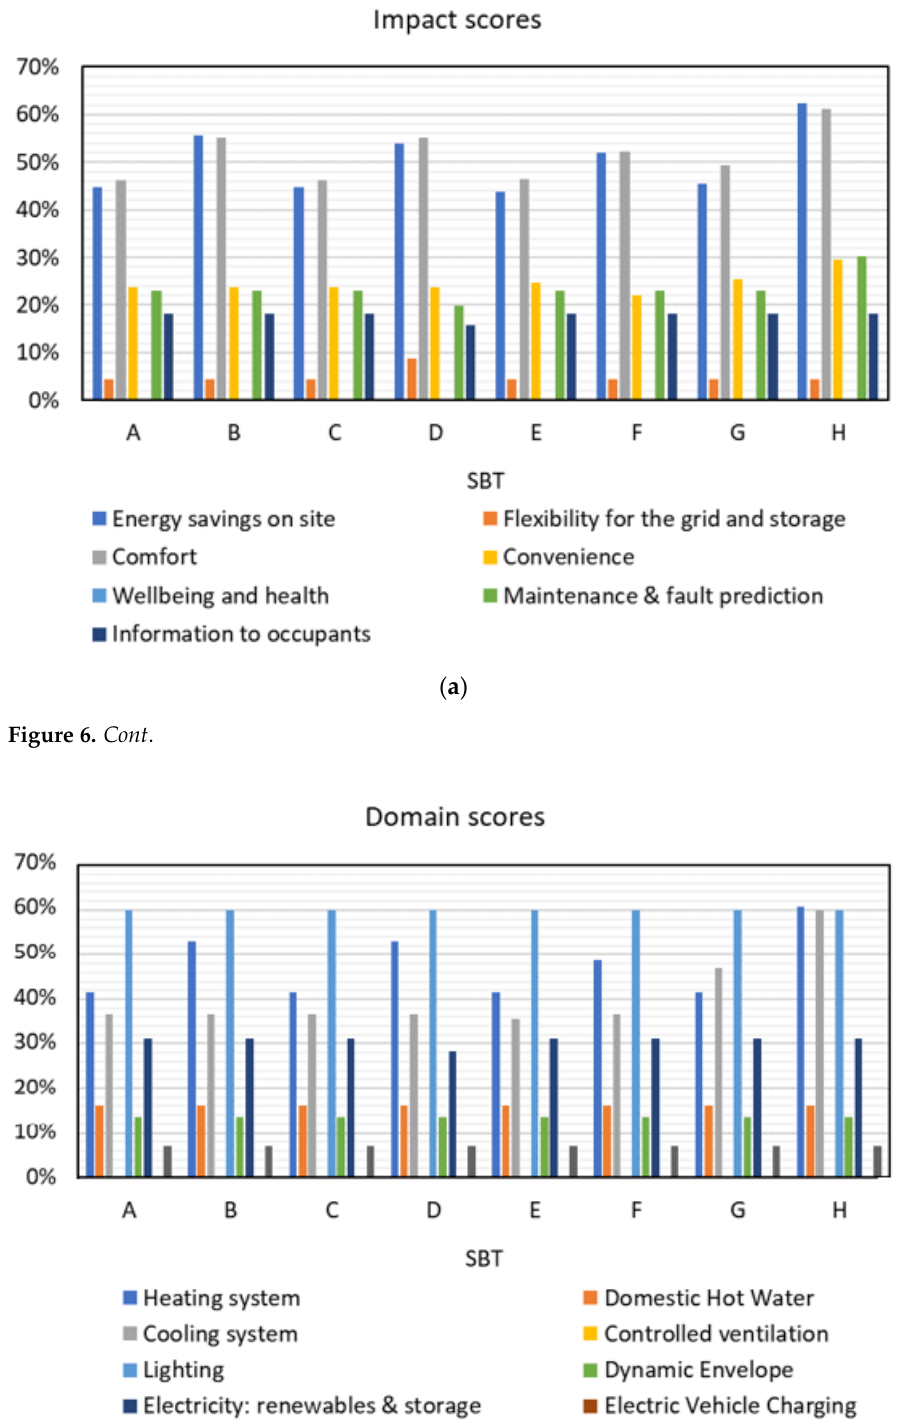
Figure 5. Impact and domain scores for each SBT in the “energy scenario”. ( a ) Impact scores and ( b ) domain scores.